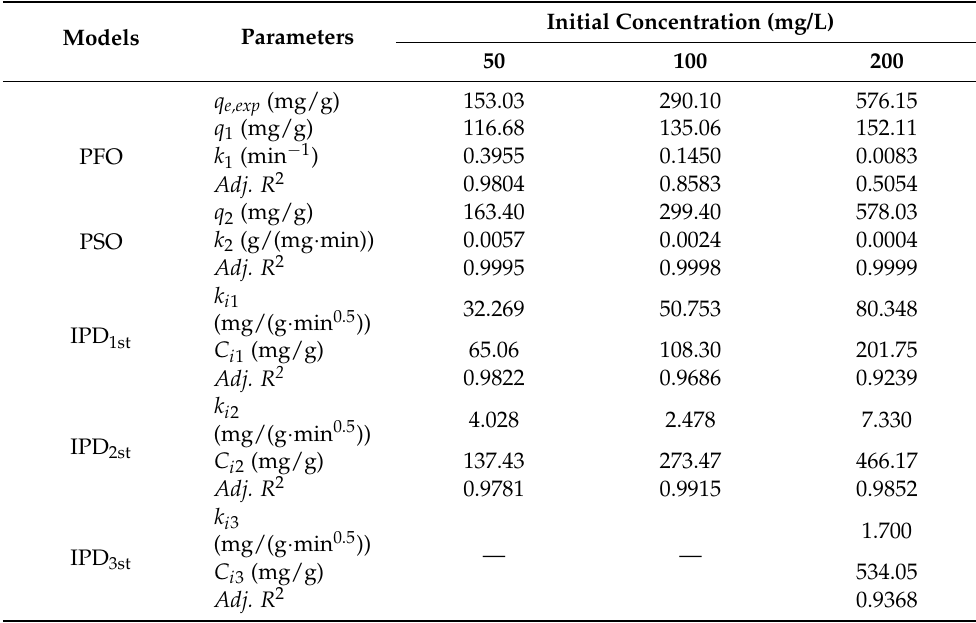
Table 2. Parameters of pseudo-first-order (PFO), pseudo-second-order (PSO), and intraparticle diffusion (IPD)